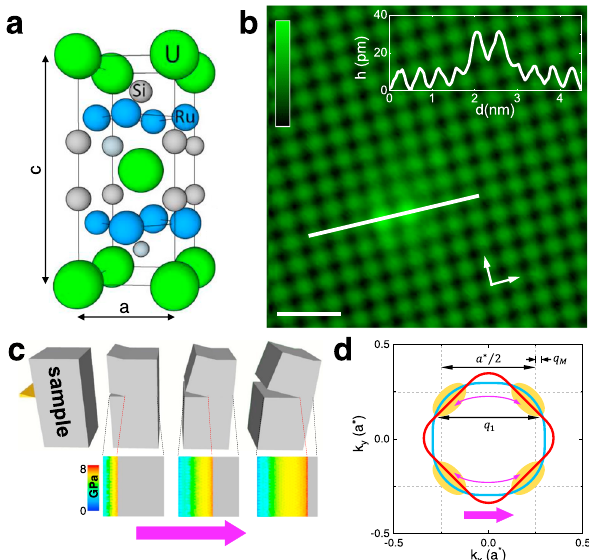
Fig. 1 Atomic size Scanning Tunneling Microscopy (STM) images of the square in-plane lattice in URu 2 Si 2 and fracture front behavior. a URu 2 Si 2 tetragonal crystalline structure ( a = 420 pm and c = 960 pm), with U atoms in green, Ru atoms in blue and Si atoms in grey. b Atomic resolution STM image showing the square U surface. The white line provides the path for the scan shown in the inset. The bias voltage is of 5.5 mV and the current is held constant at 3 nA. White arrows show the in-plane crystalline directions and the color scale the height difference, following the color bar on the upper left (from zero, black to 40 pm, green). White scale bar is 1.3 nm long. c Schematic behavior of the fracture process. At low temperatures (below 4.2 K), the sample (gray rectangular bar) is broken by bringing it close to a blade (shown in yellow). During breaking, the fracture front travels through the sample following the violet arrow and an instanteanous pressure front travels (pressure shown by the color scale from blue (0 Gpa) to red (8 GPa)). d Schematic picture of the in-plane Fermi surface of pristine URu 2 Si 2 . Red and blue lines represent the two main bands crossing the Fermi level in the paramagnetic state above the hidden order state critical temperature T HO = 17.5 K and in the plane of the tetragonal Brillouin zone. Thick violet arrow represents the travel direction of the fracture front. The interaction with electronic modes (thin violet arrows) leaves a permanent trace, which consists of a moiré whose wavenumber q M is determined by half the reciprocal unit cell a * and the vector q 1